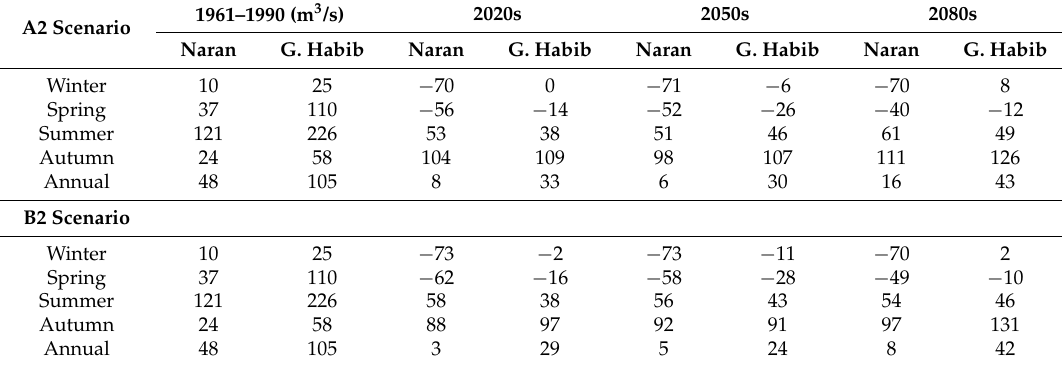
Table 4. Future changes (%) in streamflow at different gauges relative to the baseline period (1961-1990) under A2 and B2 scenarios in the Kunhar River